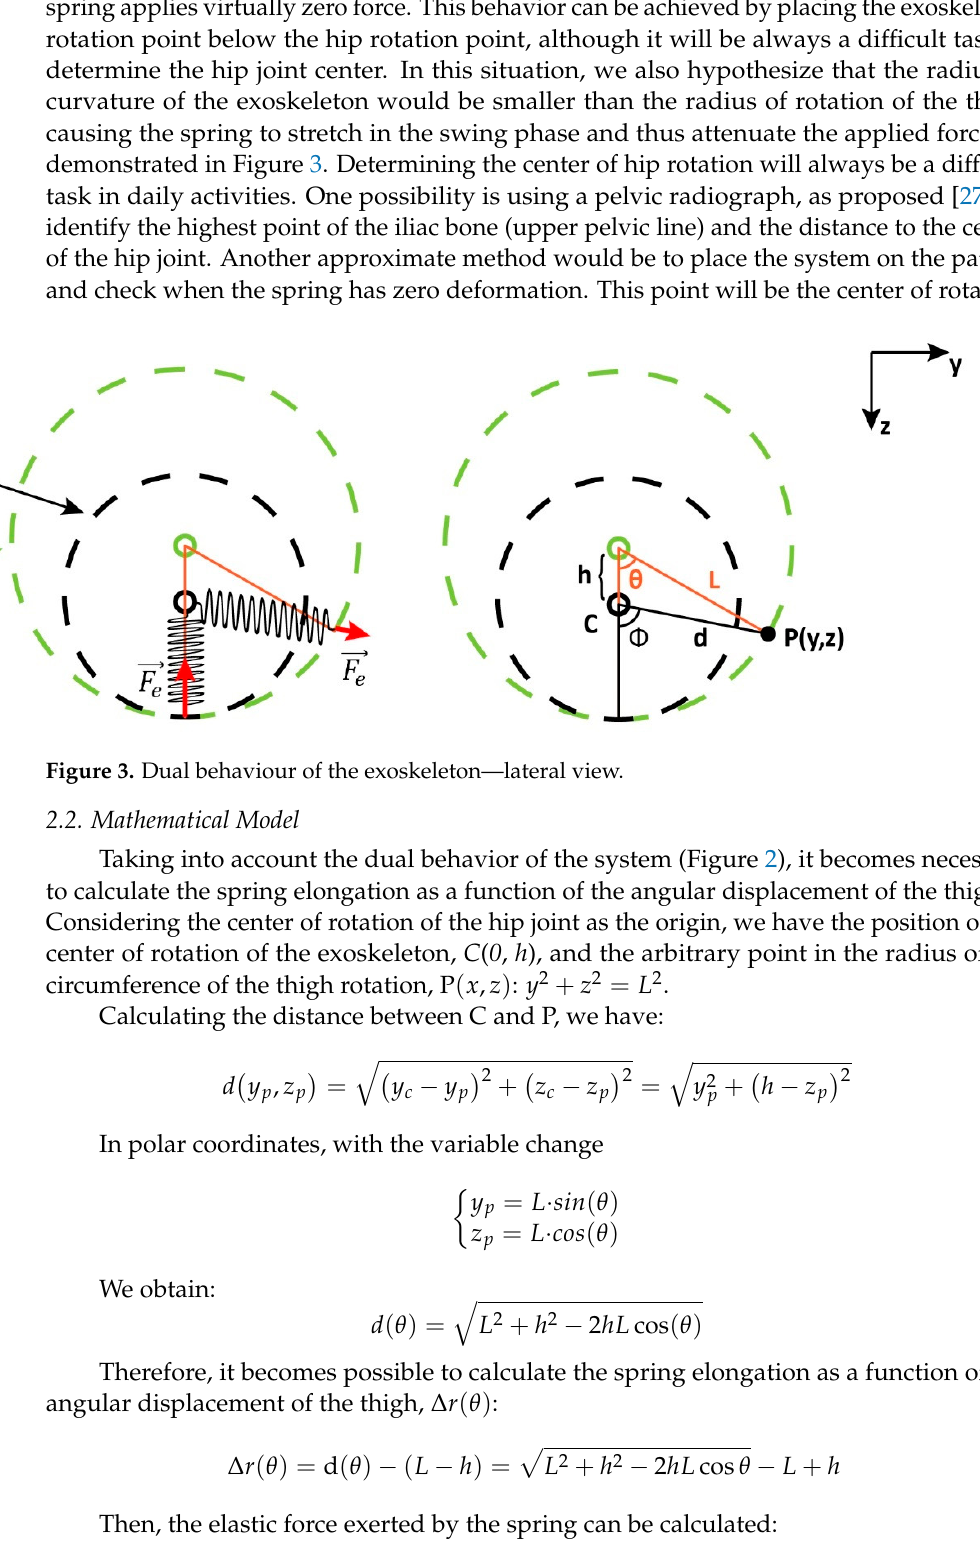
Figure 2. Rotation point of the exoskeleton superimposed with the rotation point of the hip joint: ( a ) stance phase; ( b ) swing Phase.